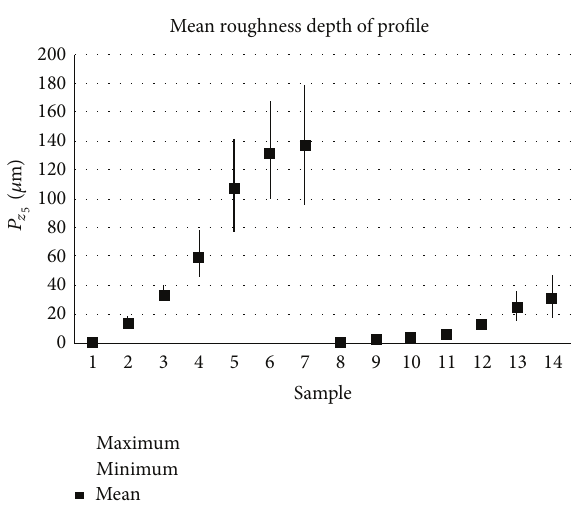
Figure 8: Results of 𝑃 𝑧5 parameter ( 𝑥 -axis).